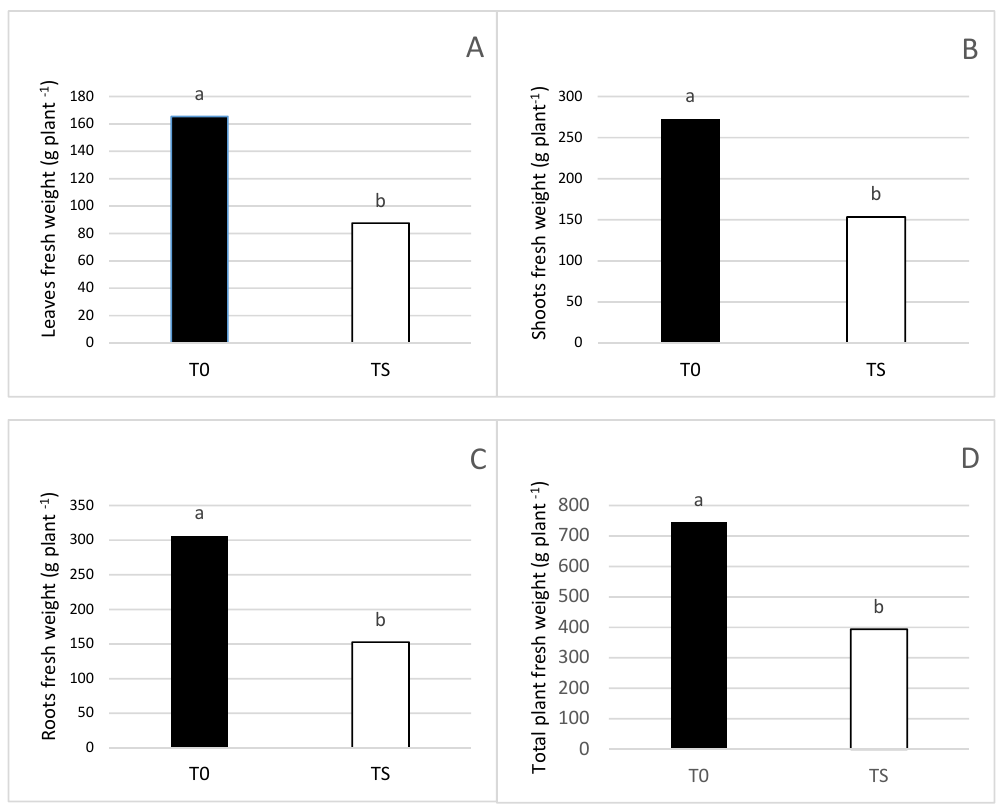
Figure 2. Fresh weight of ( A ) leaves; ( B ) shoots; ( C ) roots; and ( D ) total plant of 2 year old Hass avocado plants grown in pots subjected to T0 (distilled water) or TS (saline water (9 mM NaCl)) treatment for 240 days, with 6 replicates per treatment. Means with different letters indicate significant differences between treatments (Tukey test p <